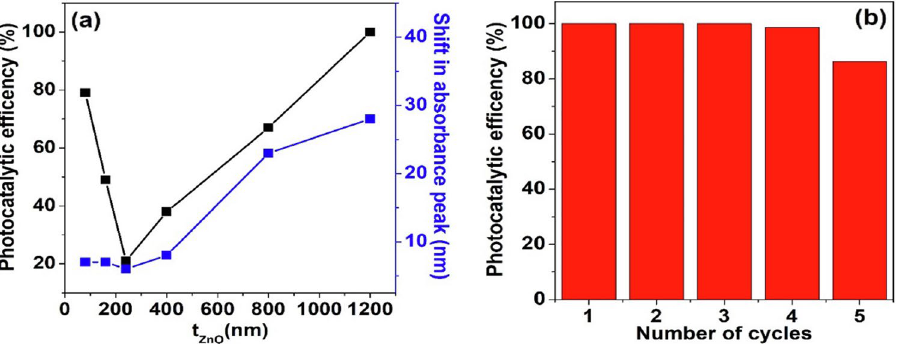
Fig. 7 a Photocatalytic effi- ciency and shift in absorbance peak of RhB dye as a function of t and b Reusability test ZnO of ZnO